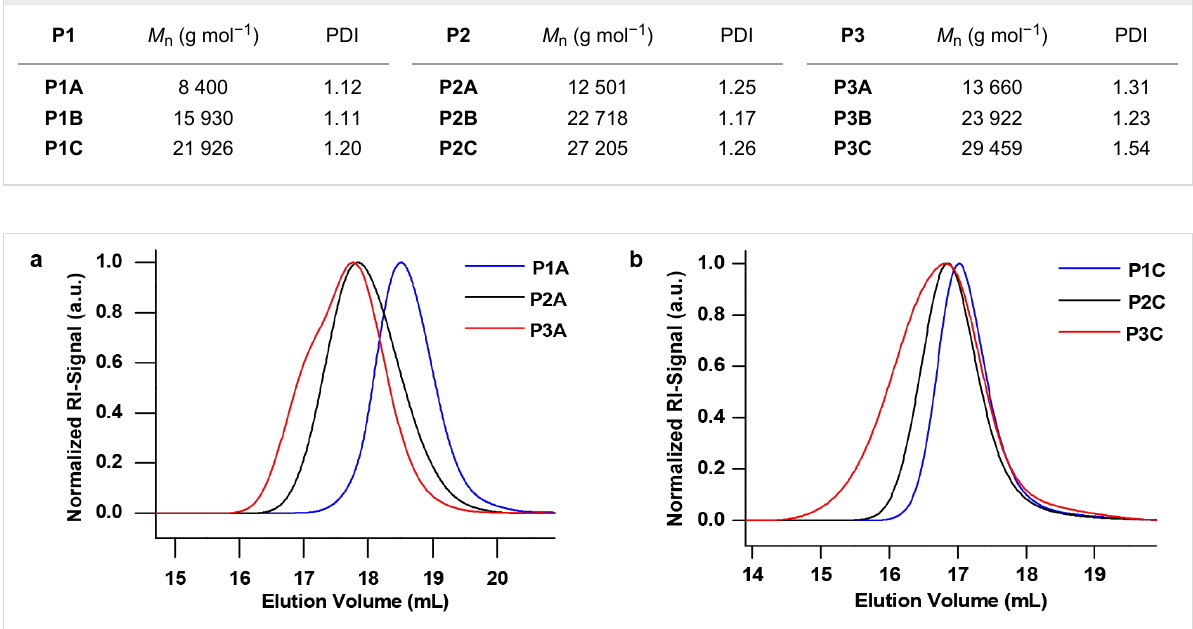
Table 1: Molecular weight and polydispersity of all synthesized polymers. P1A–C represents the PIL block. P2A–C represent the block copolymer and P3A–C the polymer after post-polymerization. P1